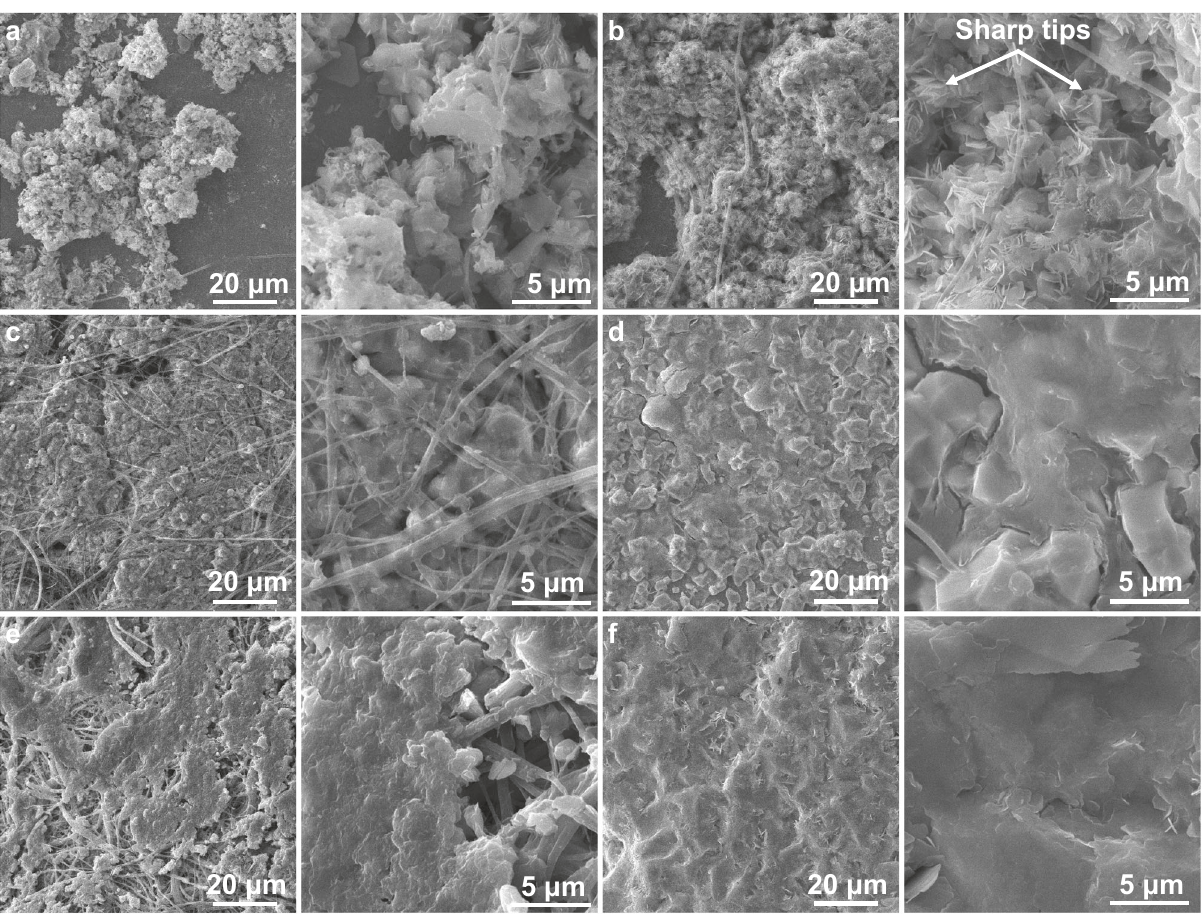
Fig. 4 SEM images of the electrodes after Zn deposition at 1 mA/cm 2 . Zn deposition on Ti current collector using pristine separator with a cycling capacity of a 1 mAh/cm 2 and b 4 mAh/cm 2 ; Zn deposition on Ti current collector using Sn-coated separator with a cycling capacity of c 1 mAh/cm 2 and d 4 mAh/cm 2 ; Zn deposition on Sn-coated separator with a cycling capacity of e 1 mAh/cm 2 and f 4 mAh/cm 2